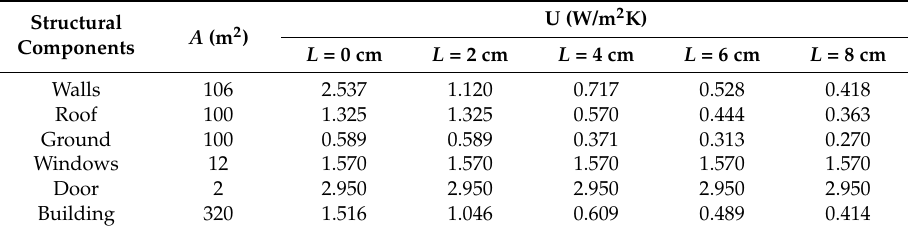
Table 4. Thermal transmittance (U) of structural